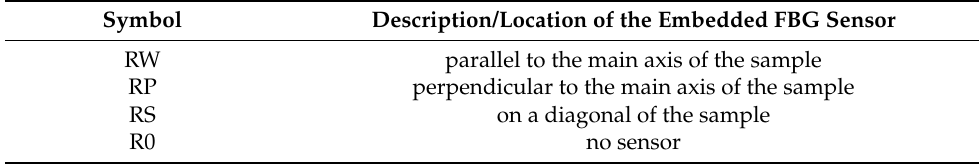
Table 4. Samples